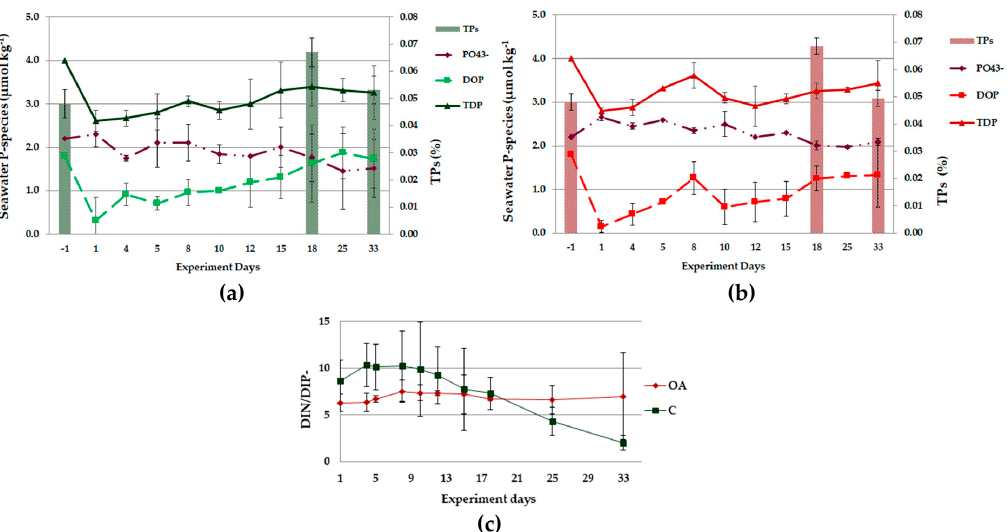
Figure 9. Phosphate, DOP concentrations (in μ mol kg − 1 ) and sedimentary TP (in %) for the duration of the experiment for C ( a ) and OA ( b ) conditions; DIN:DIP ratio for both conditions ( c ); (x-axis: days of the experiment; mean values and standard deviations for the two replicates of each treatment).